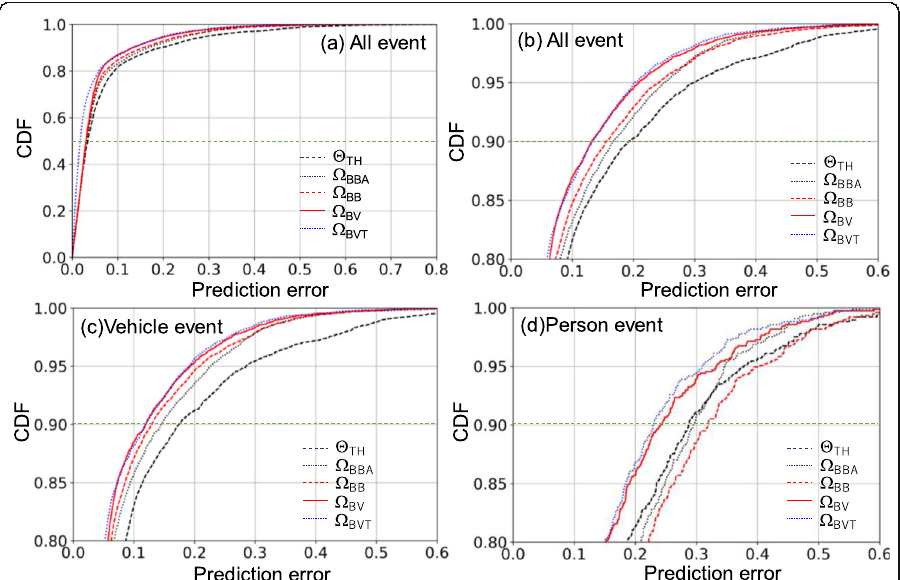
Fig. 11 CDFs of the prediction error using the input feature sets for T F of 1.0 [s]. a CDF in the range from 0 to 1.0 for all-event dataset, b CDF in the range from 0.8 to 1.0 for all-event dataset, c CDF in the range from 0.8 to 1.0 for vehicle event, and d CDF in the range from 0.8 to 1.0 for person